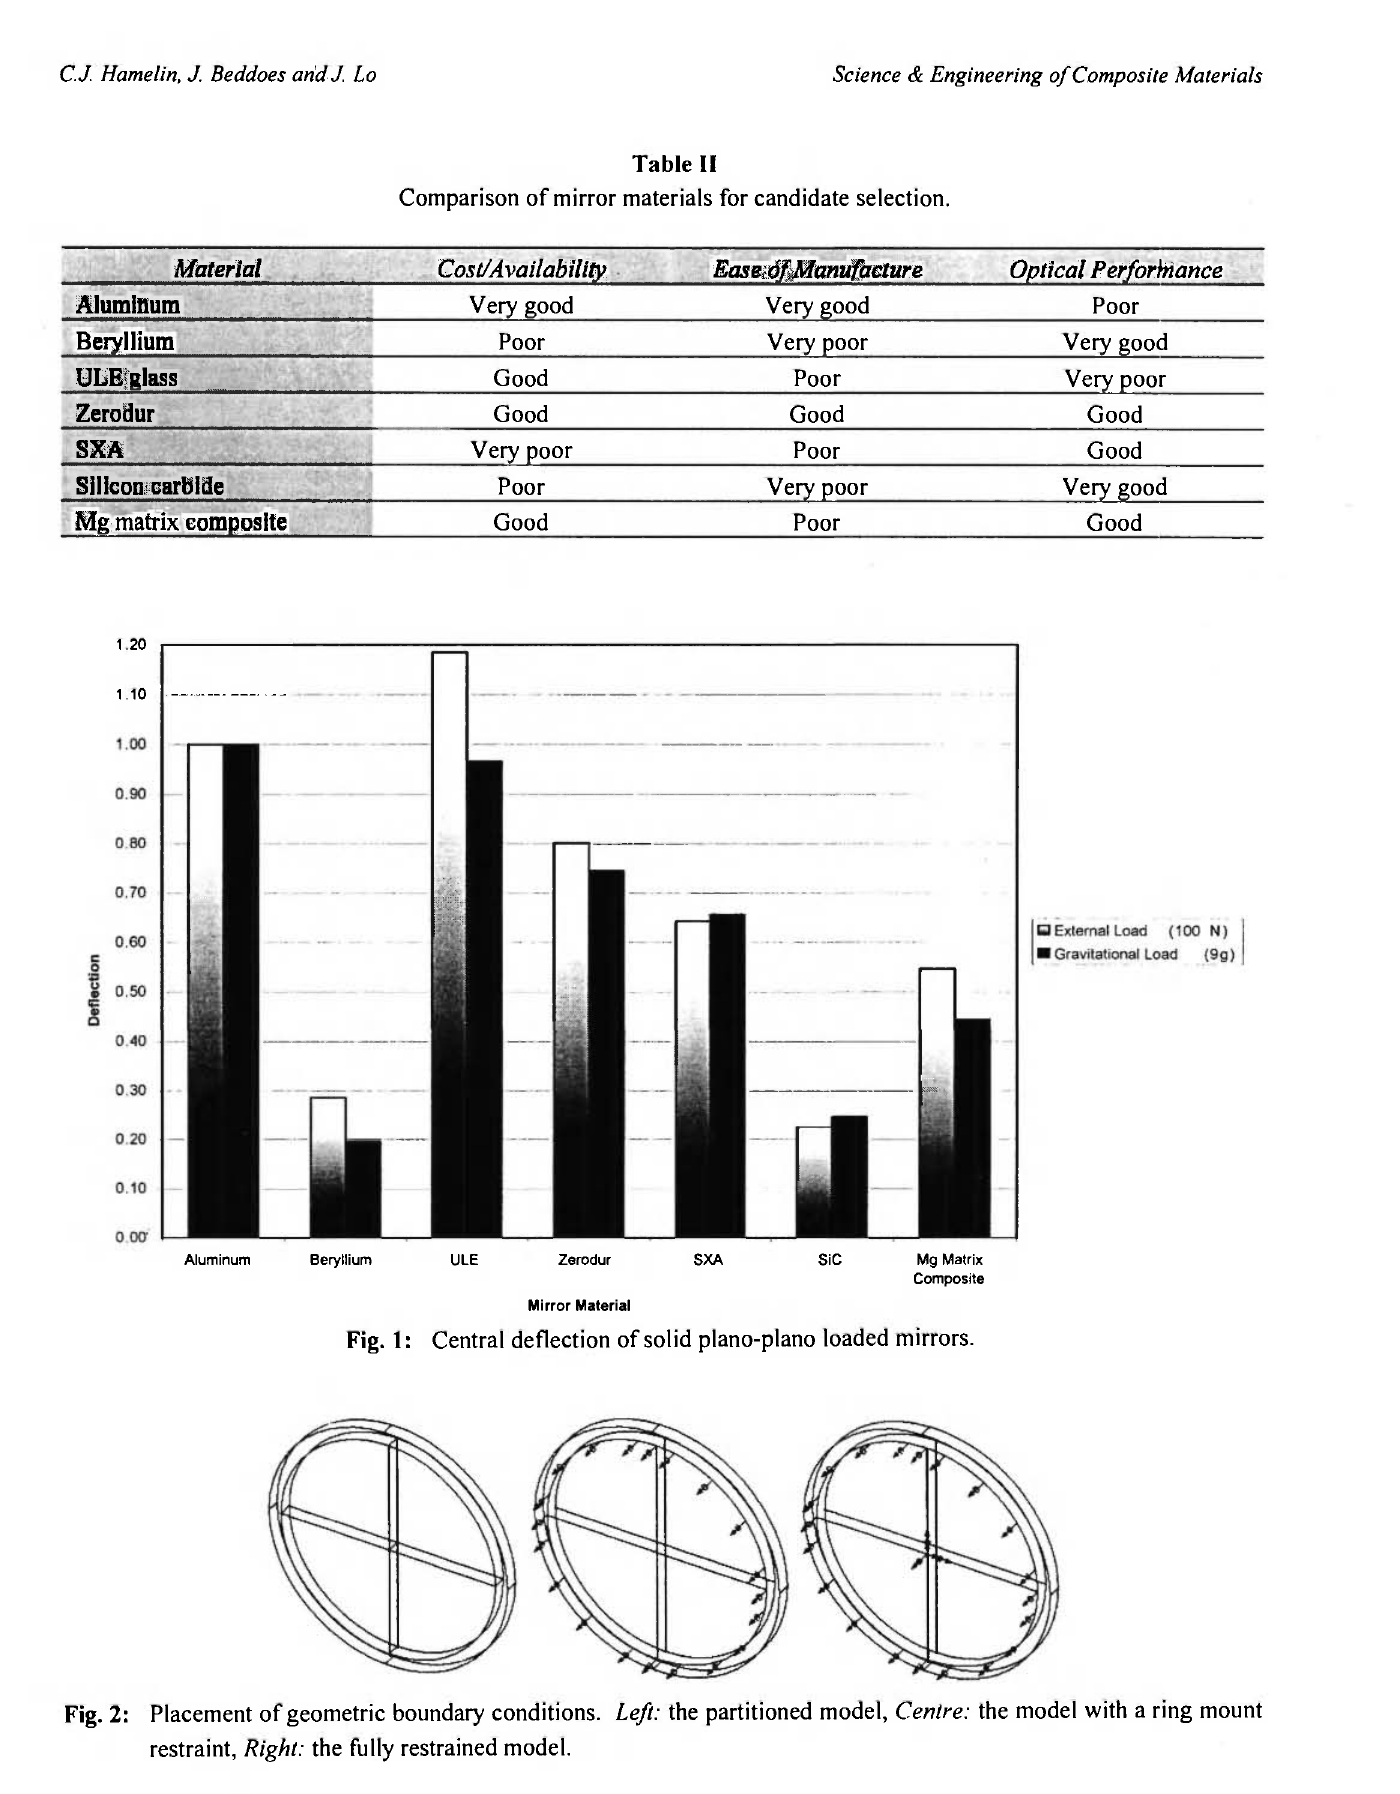
Fig. 2: Placement of geometric boundary conditions. Left: the partitioned model, Centre: the model with a ring mount restraint, Right: the fully restrained